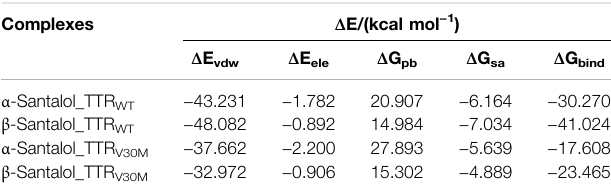
TABLE 1 | Δ E vdw , Δ E ele , Δ G pb , and Δ G sa were calculated by the molecular mechanics/Poisson-Boltzmann surface area approach for TTR WT and TTR V30M proteins in complex with santalol isomers along with the corresponding binding free energies.